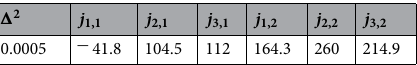
Table 3. Estimated flux rates after minimization.